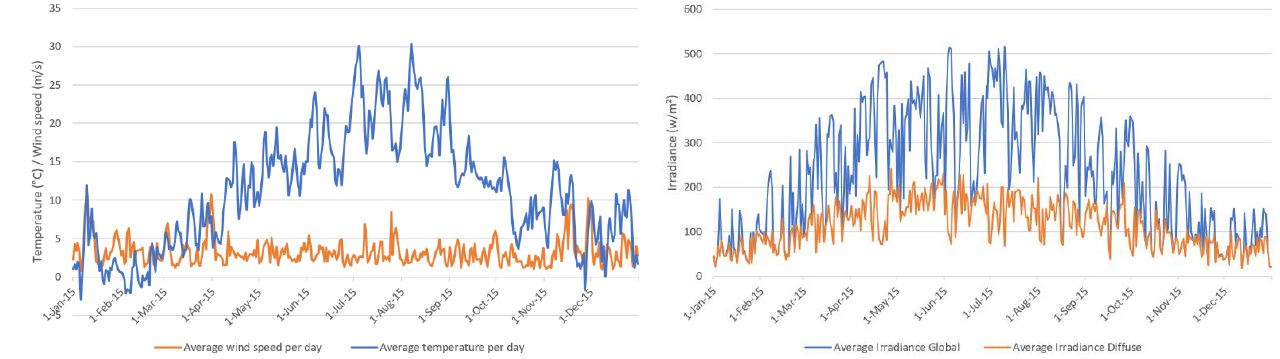
Figure 1. Input temperature and wind speed data (daily averaged values) ( left ) and input global and diffuse irradiance (daily averaged values) ( right ).